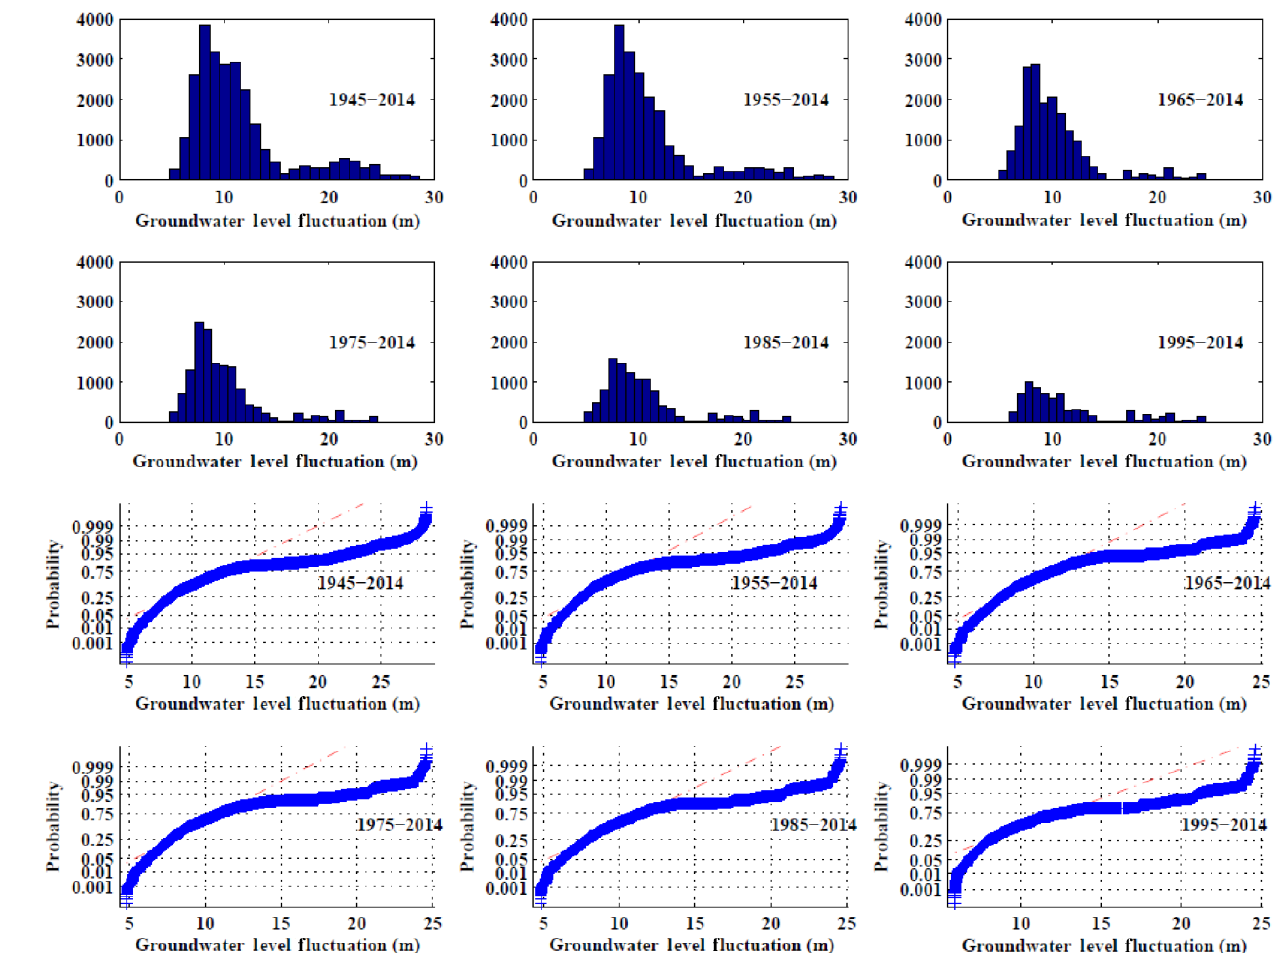
Figure 10. Histograms and normal probability plots for various time intervals of groundwater levels of Well